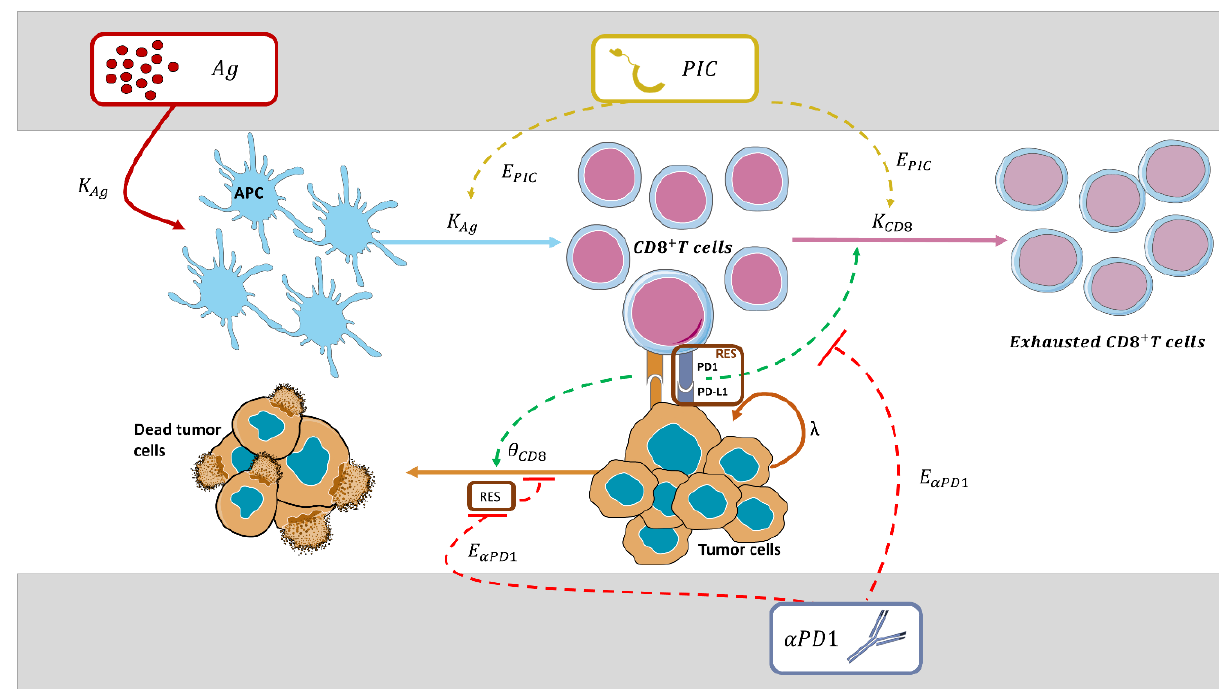
Figure 2. Schematic representation of the immuno-oncology therapy model, including the interactions of immune cells with cancer cells after the administration of antigen Ag, PIC, and α PD1. Dashed green arrows indicate activation, dashed red blocked arrows indicate inhibition, dashed yellow arrows indicate the effect of PIC, and solid sharped arrows indicate the transit between compartments. TRT and TR denote treatment and transit compartments, respectively. APC stands for antigen-presenting cells, and RES for the resistance mechanisms developed by the tumor. A description of the parameters can be found in Material and